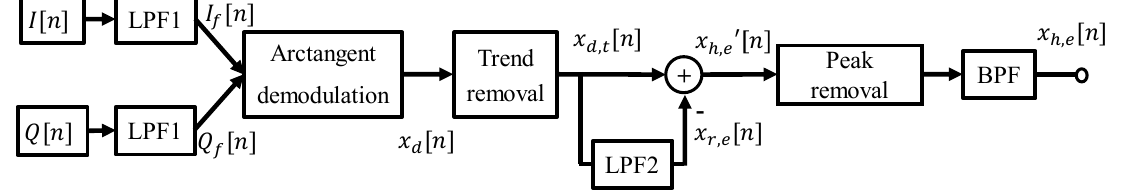
Figure 2. Digital signal processing for vital sign extraction.